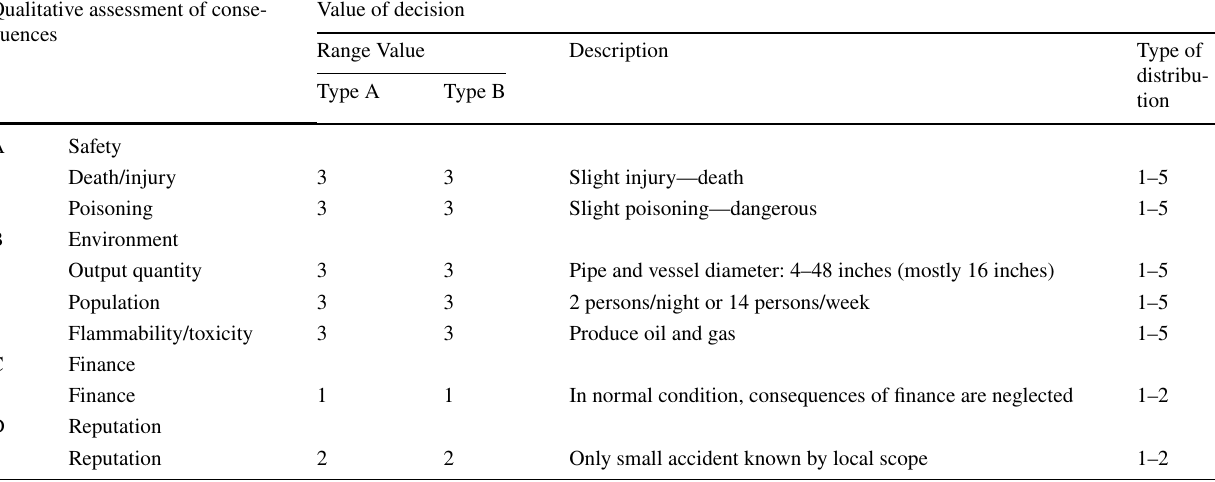
Table 7 Qualitative assessment of consequences Qualitative assessment of conse-